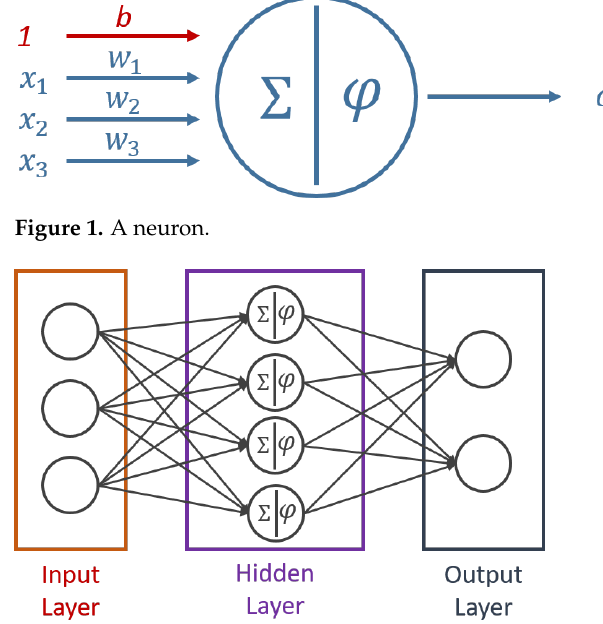
Figure 2. A neural network with one hidden